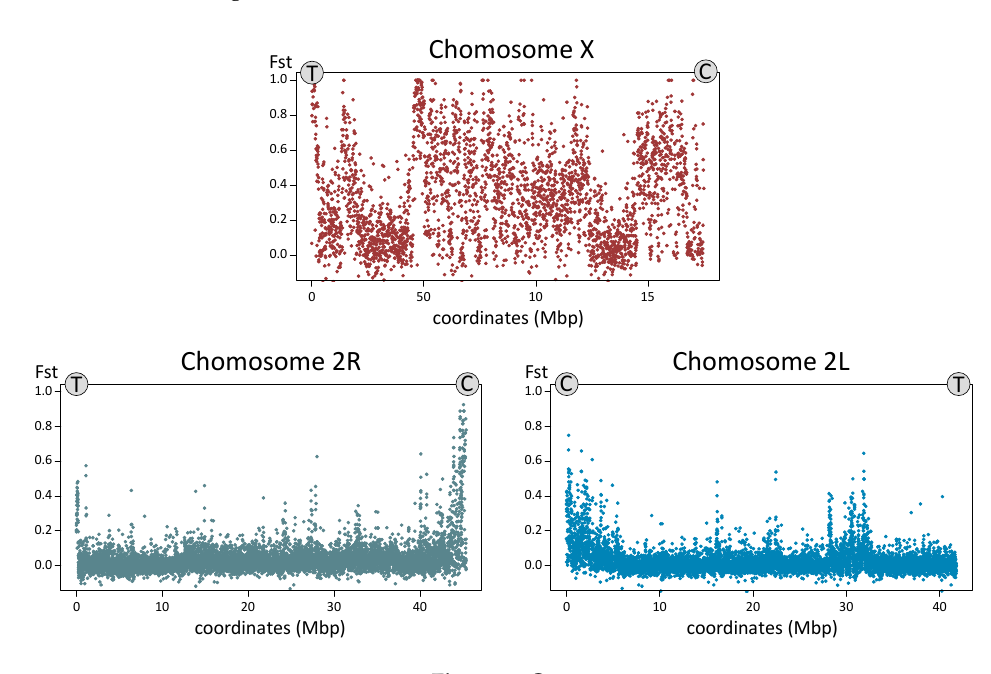
Figure 7. Level of genetic differentiation (Fst) between An. messeae (n = 5) and An. daciae (n = 5) along the chromosomal arms. Each dot represents a 5 kb window. The y-axis represents Fst values and the x-axis represents the genomic coordinates (Mbp). The X chromosome demonstrates the highest Fst values while the autosomal arms have a low overall level of differentiation, which is elevated in the centromeric regions. T and C stands for telomeres and centromeres, respectively. 0